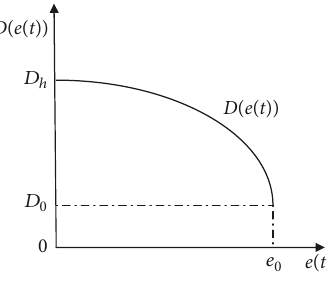
Figure 4: The function graphic of 𝐷(𝑒(𝑡))